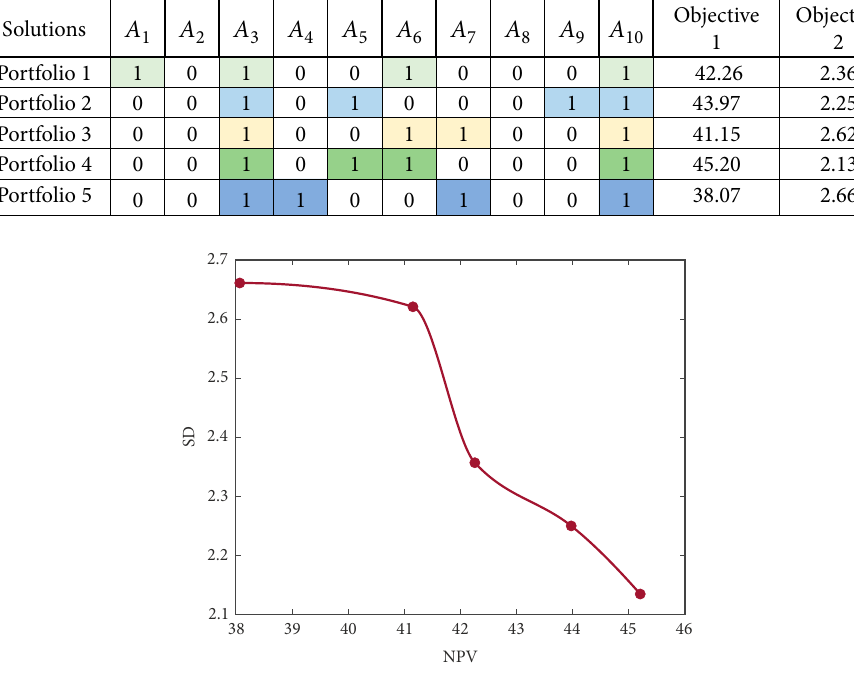
Figure 2. The pareto front of Model